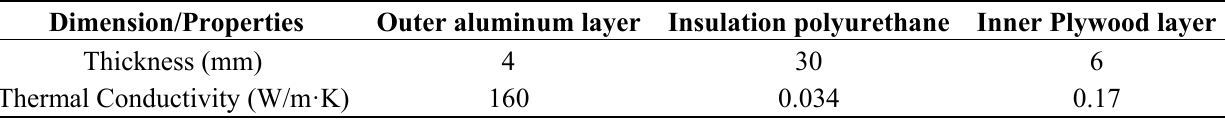
Table 3. Thermal properties of the layers of the